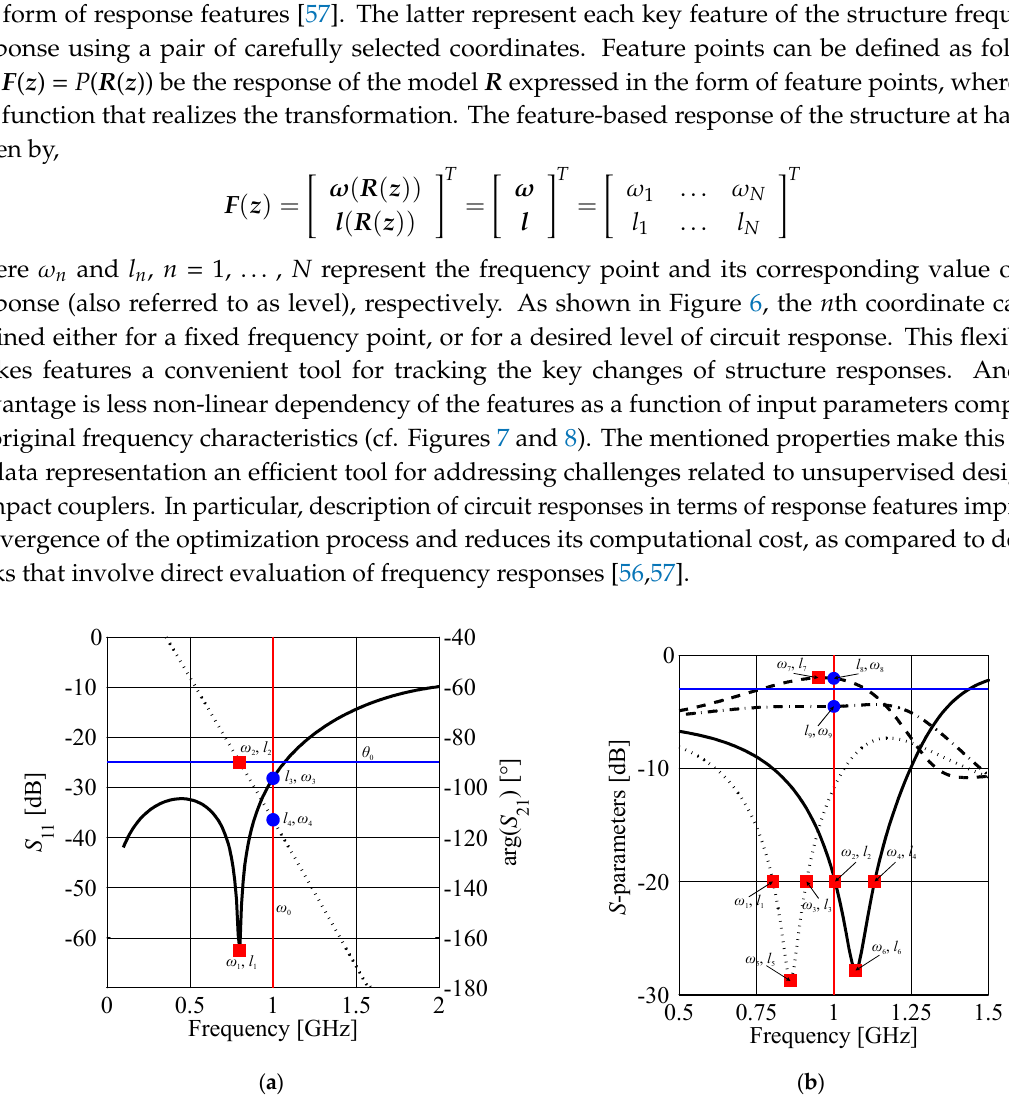
Figure 6. Representation of structure characteristics in the form of feature points: ( a ) individual cell and ( b ) coupler. The squares represent feature points defined w.r.t. level (i.e., frequency point for the given level l ). The circles are features defined w.r.t. frequency (i.e., response level for the given frequency point ω ). Parameters ω 0 and θ 0 represent the center frequency and the desired phase shift.